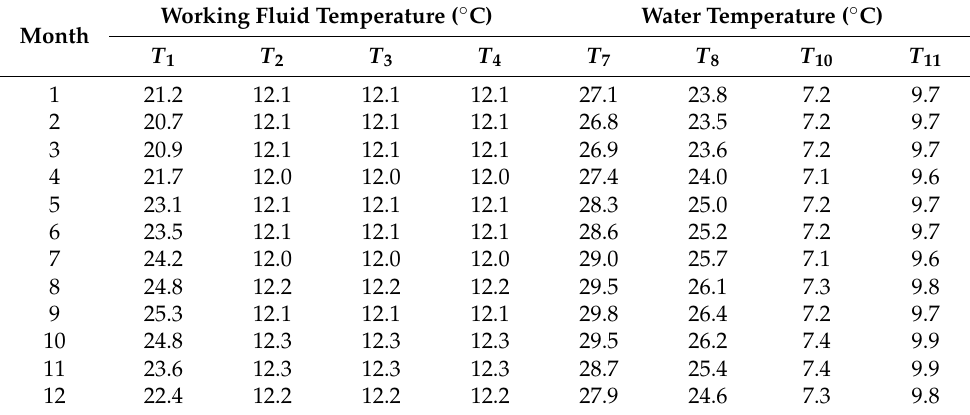
Table A3. Inlet and outlet temperature for maximum power output, using HYCOM temperature data and minimum working fluid rate.